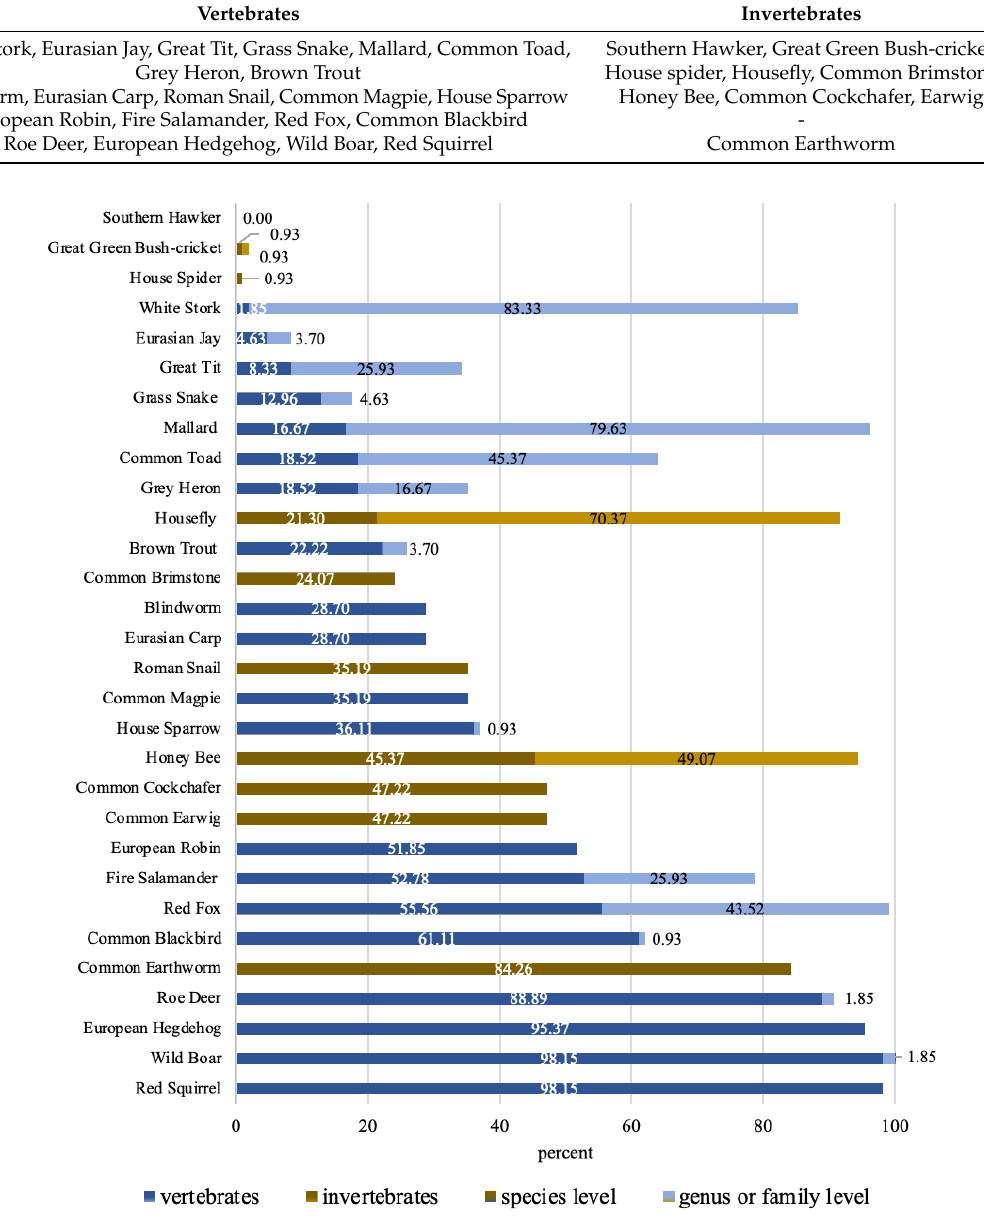
Figure 2. Identification rates of the animal species; blue: vertebrates, gold: invertebrates; light: identification on genus/family level; dark: identification on species level; N = 108.